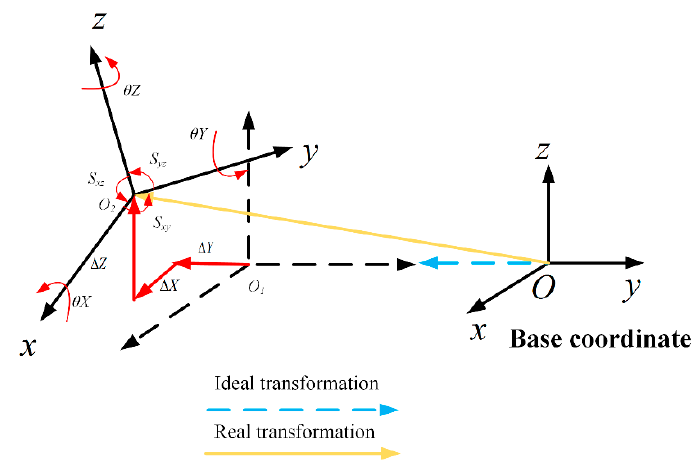
Figure 4. Error components and homogeneous coordinate transformation. Table 3. Components of geometric errors.